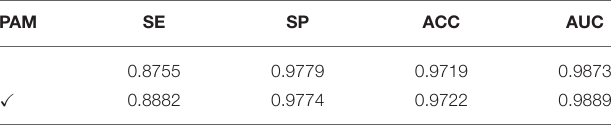
TABLE 4 | Ablation study for patch attention module (PAM).